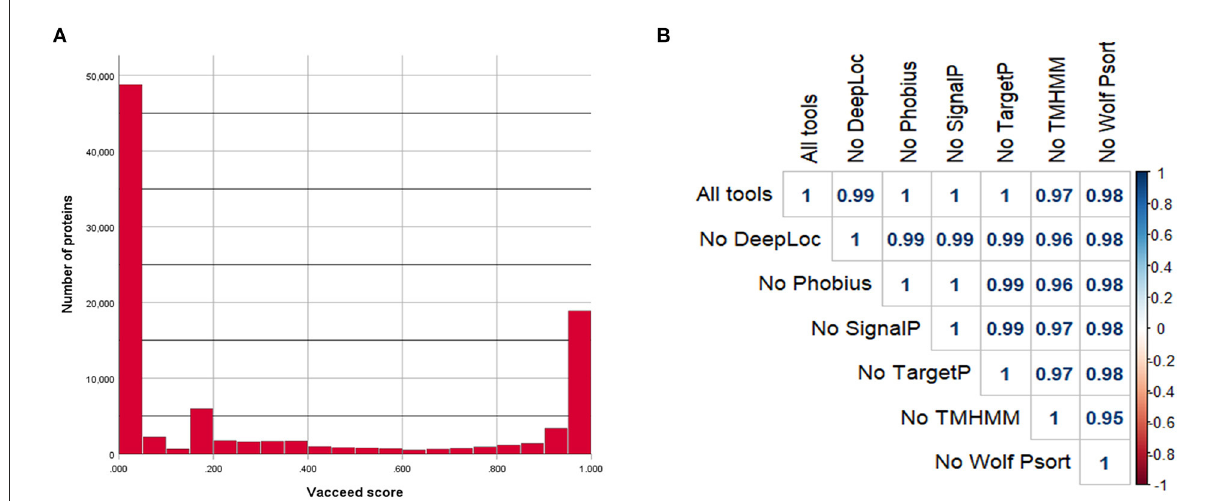
FIGURE1 Vacceed assessment. (A) Vacceed final scores and respective number of proteins for all analyzed protein sequences. (B) Pearson correlation plot of the different Vacceed assessments. Each value corresponds to the Pearson correlation coefficient between all the protein sequence scores in two different runs (All tools, Vacceed with all the used tools; No DeepLoc, Vacceed without the tool DeepLoc; the other labels follow the same